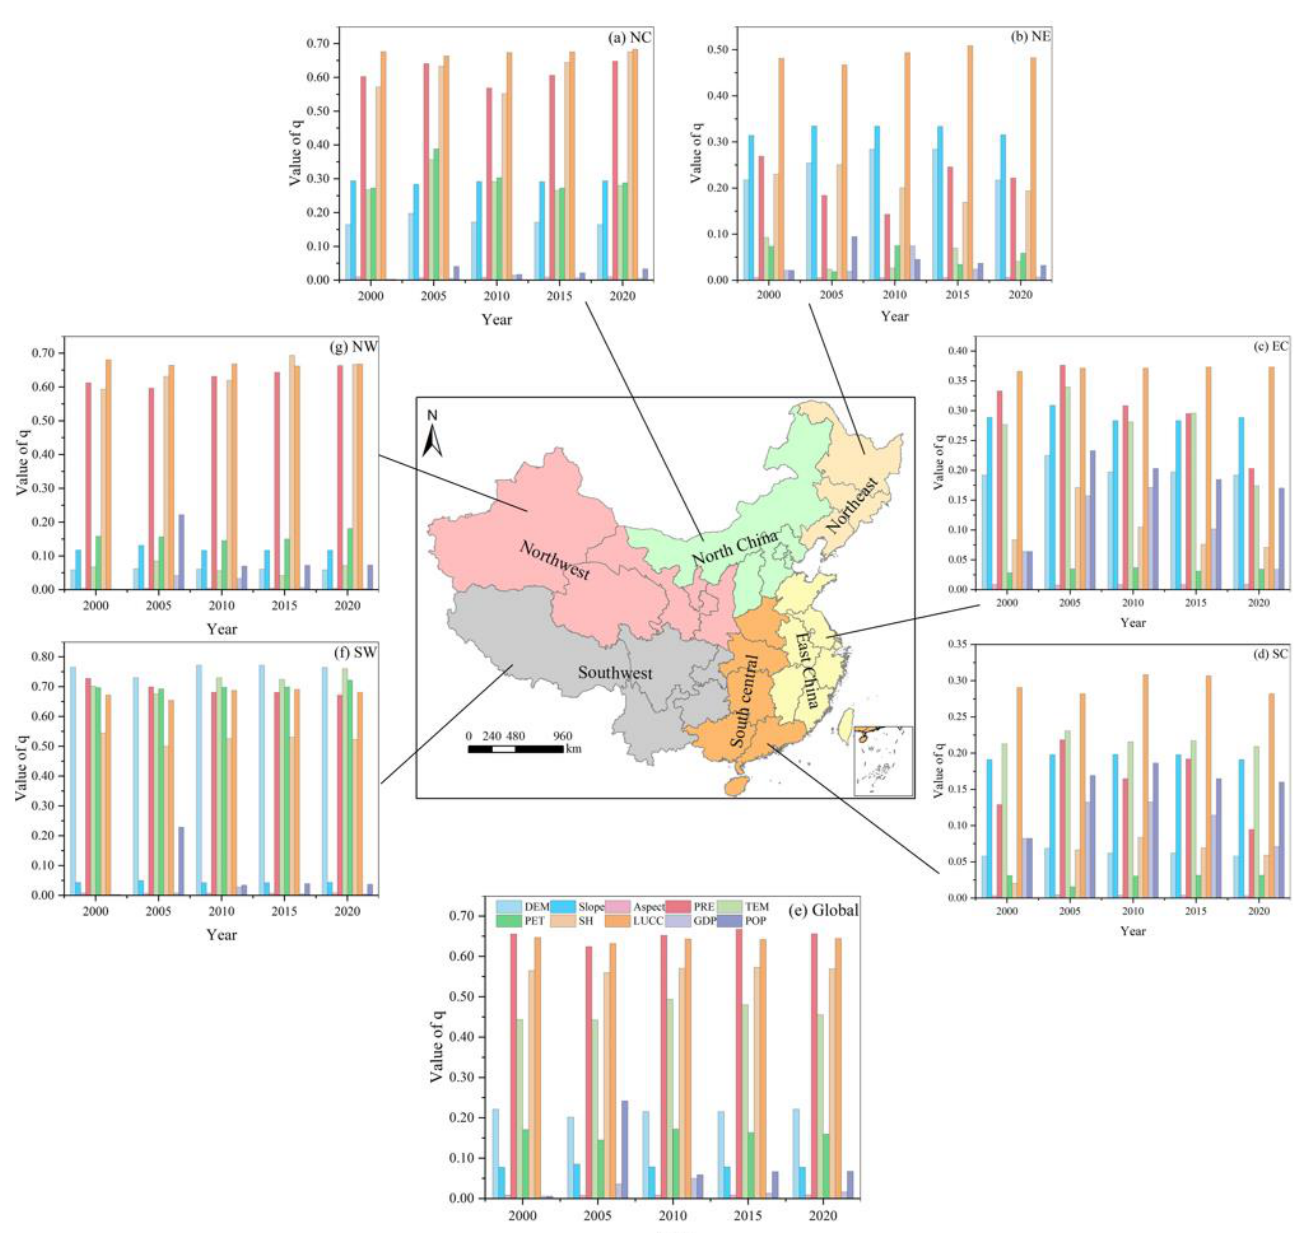
Figure 6. Changes in the q values of influential factors in China during 2000 – 2020.